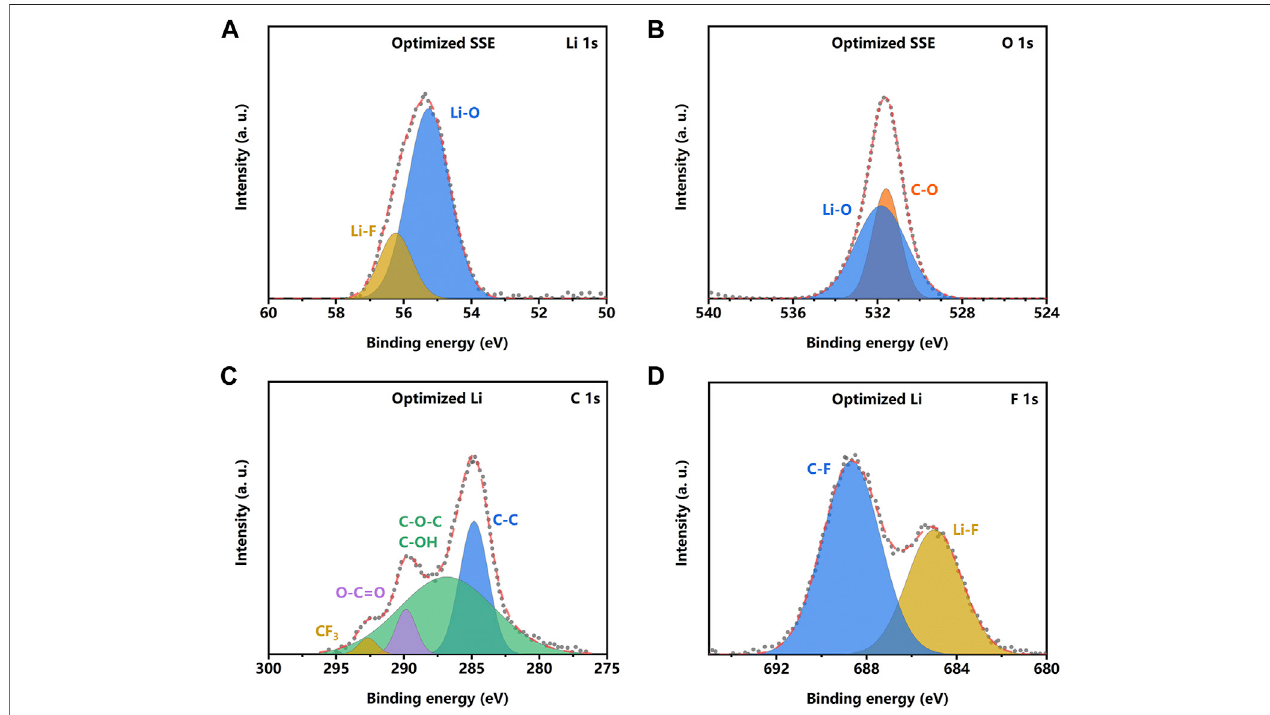
FIGURE 5 | X-ray photoelectron spectroscopy (XPS) data and simulated peaks of Li 1s (A) and O 1s (B) of the solid-state electrolyte (SSE) surface in a symmetric cell with LE-optimization. XPS data and simulated peaks of C 1s (C) and F 1s (D) of the Li metal surface in a symmetric cell with LE optimization.